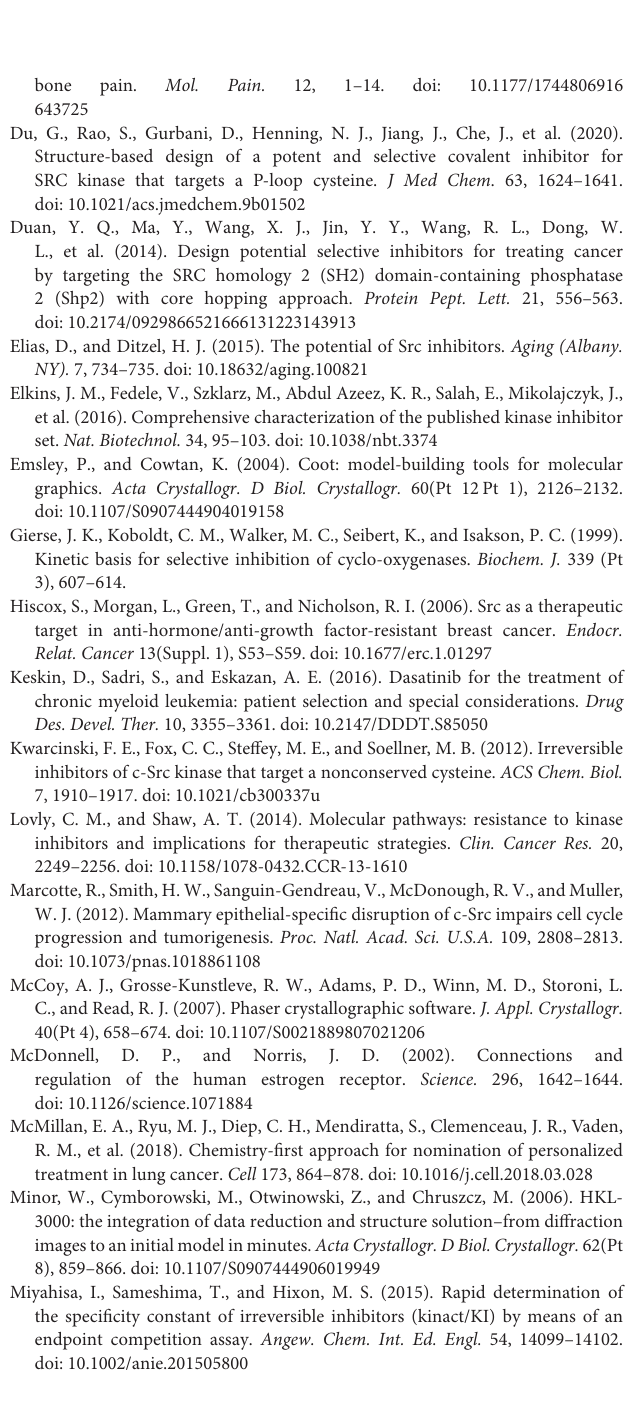
Figure S2 | Src C280S efficiently phosphorylates the peptide substrate. Percent conversion from non-phosphorylated to phosphorylated substrate is shown over time for a range of Src concentrations. Each data point represents a triplicate measurement. (A) WT Src. (B) Src C280S . Figure S3 | Differences between protomers in the asymmetric crystallographic unit. All 8 protomers were superimposed and each colored differently. Figure S4 | Covalent docking model predicts hydrogen bonding interactions for linker